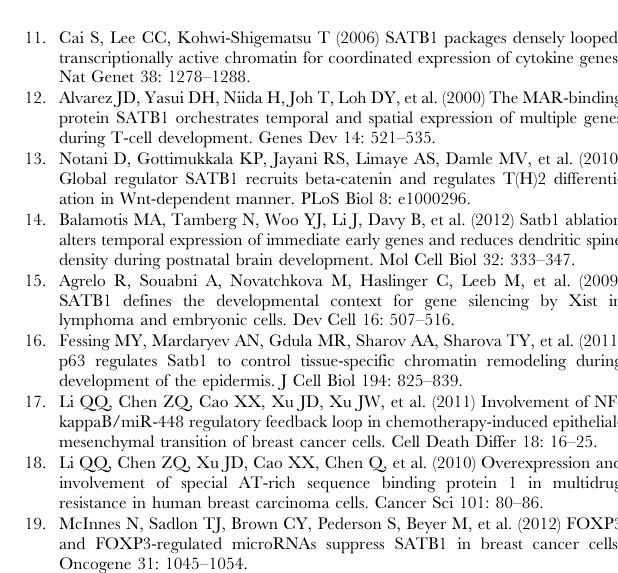
checkpoint of MCF10A-1. Cell cycle profiles are representative of three experiments. Figure S5 A ) Quantitative RT-PCR analysis for ATM expres- sion normalized to GAPDH. RNA and cDNA were prepared